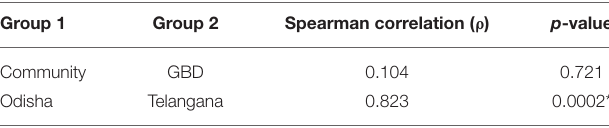
TABLE 4 | Comparison of the community disability weights with GBD 2015